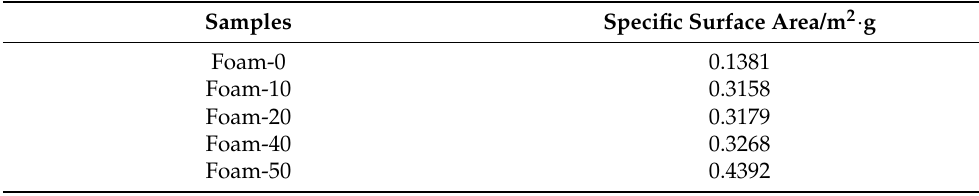
Table 2. Specific surface area and pore volume of the composite foams.